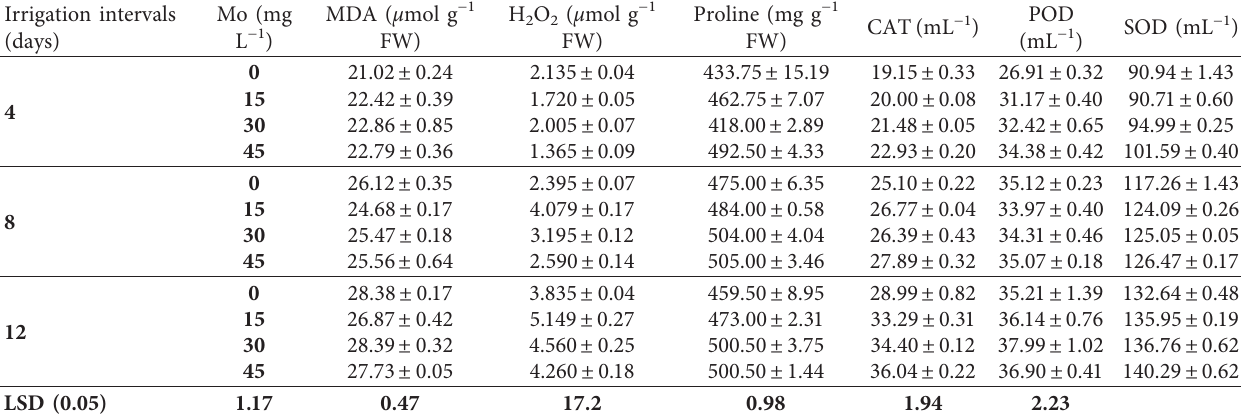
Table 5: The effect of interaction between Mo concentration and irrigation intervals on some biochemical traits of the mung bean crop (Means ± SE). Irrigation